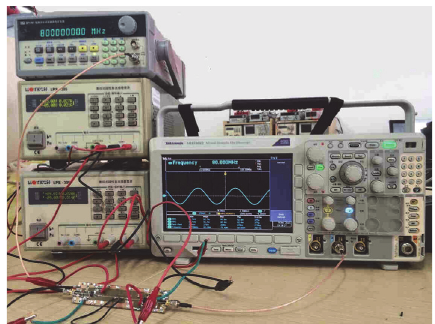
Figure 8: The experiment setup for measuring